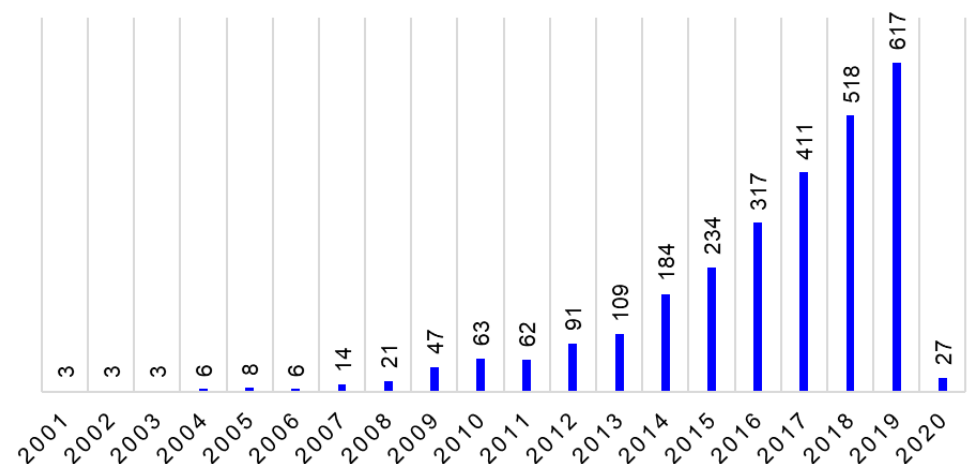
Figure 5. Number of journal papers containing multi/bi and objective and optimization/optimisation